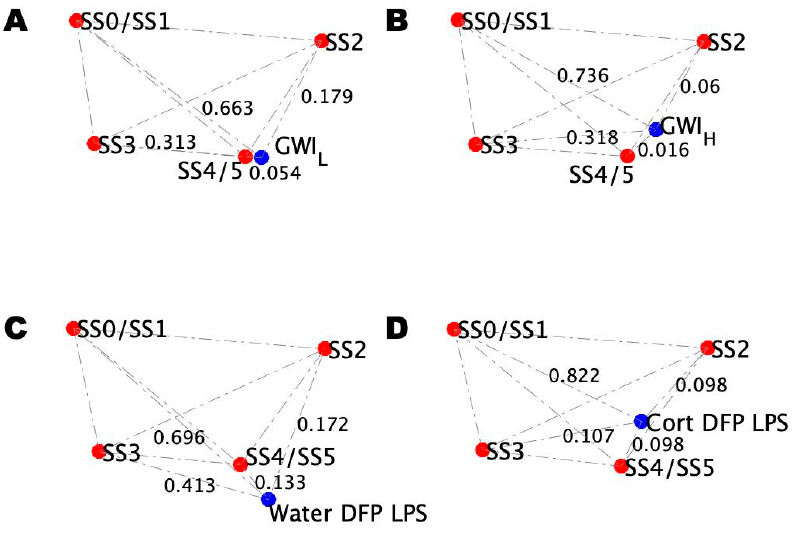
Figure 7. Comparison of the GWI trauma subtype blood profile topologies with mouse models under challenge. ( A ) Topology of the distance between the simulated stable states for GWI L at peak exercise. ( B ) Topology of the distance between the simulated stable states for GWI H at peak exercise. ( C ) Topology of the distance between the simulated stable states of mice receiving a course of pure drinking water, an injection of DFP, and a follow-up injection of LPS. ( D ) Topology of the distance between the simulated stable states of mice receiving a course of drinking water with CORT, an injection of DFP, and a follow-up injection of LPS.